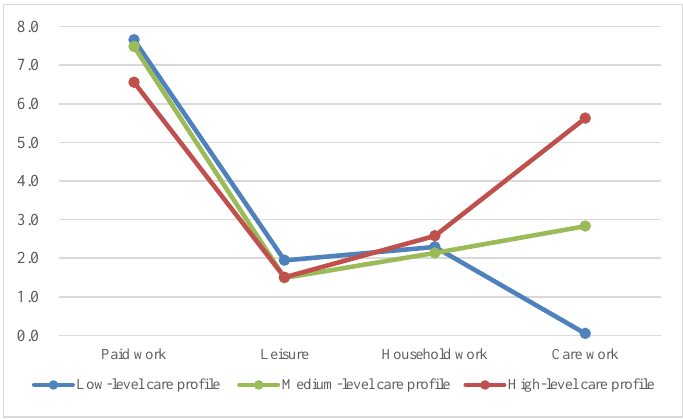
Figure 2. Time-use profiles of working moms.